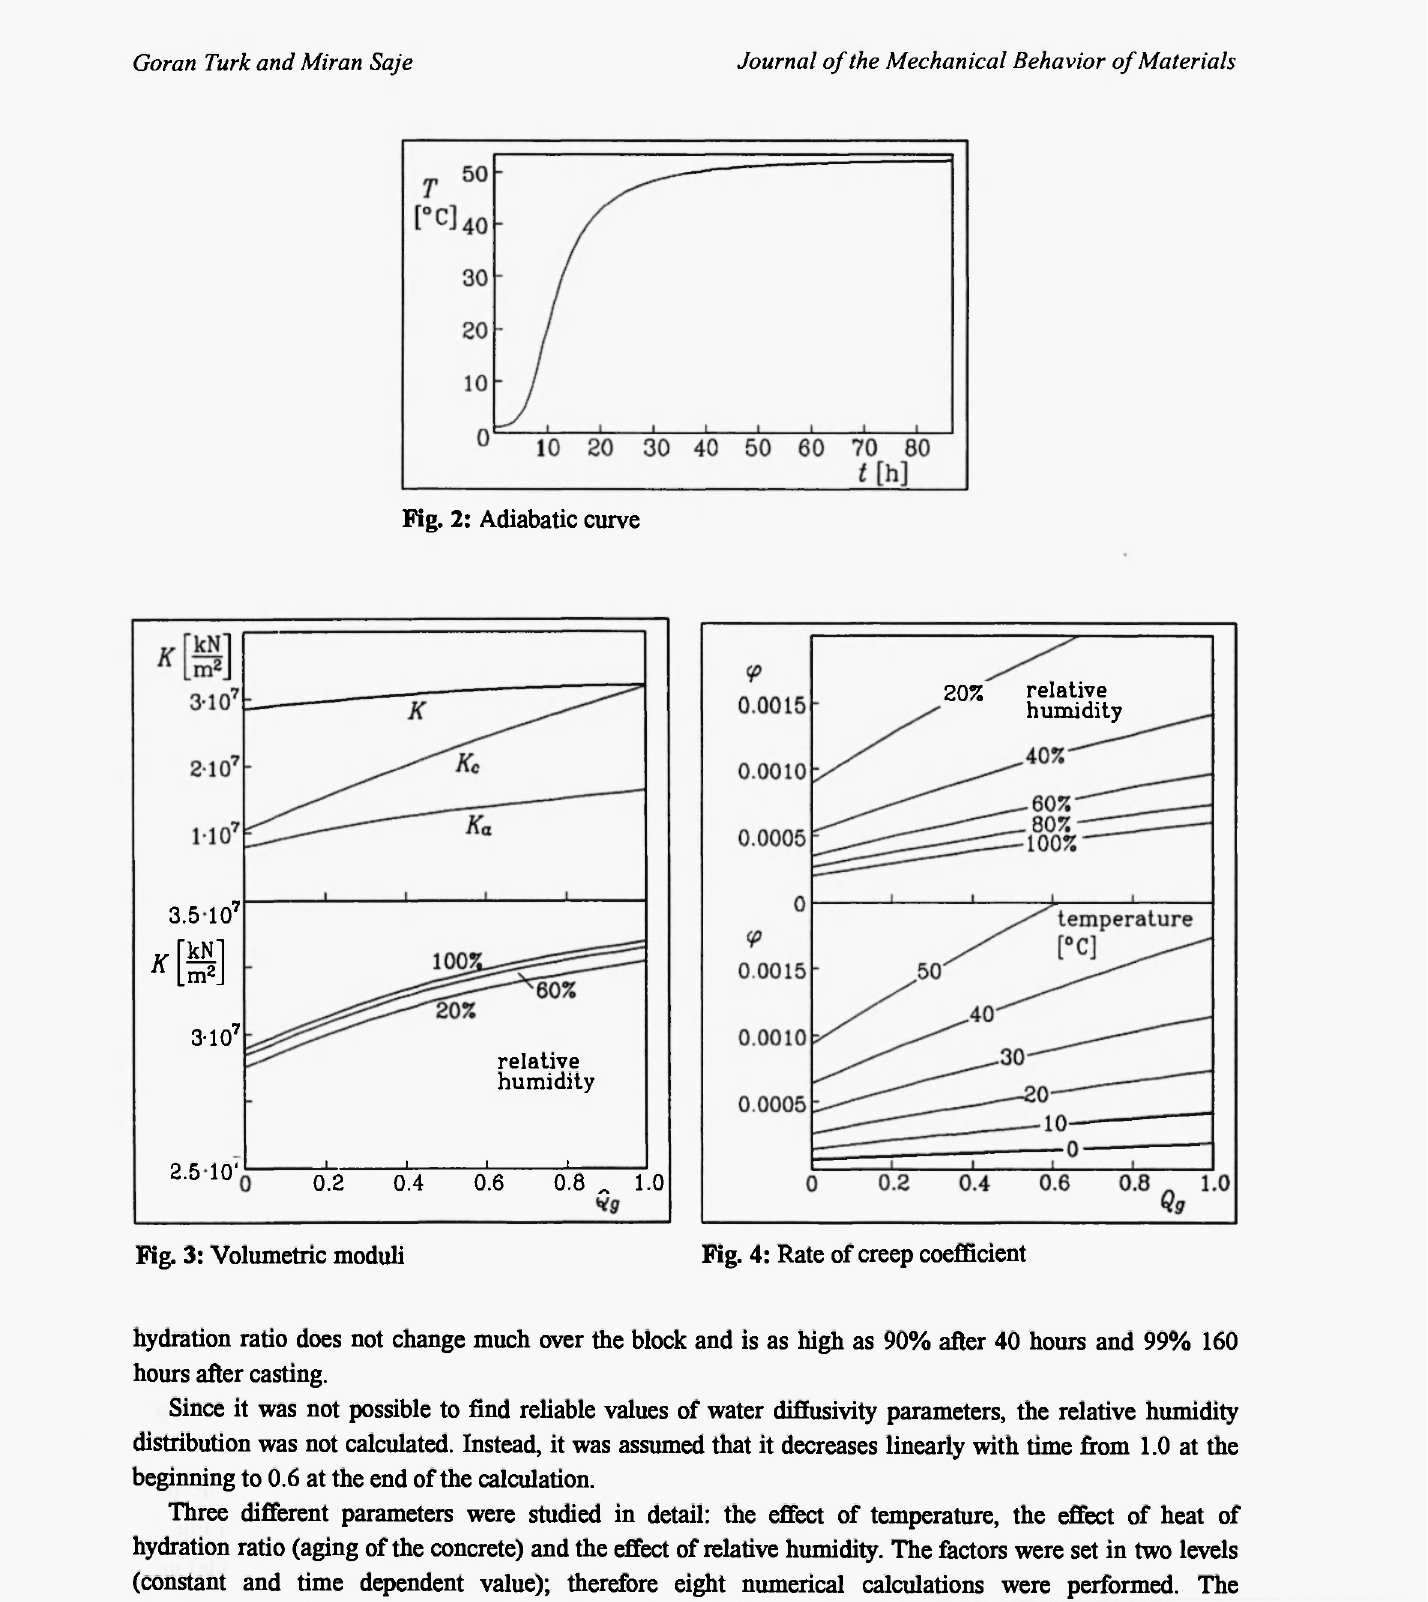
Fig. 3: Volumetric moduli Fig. 4: Rate of creep